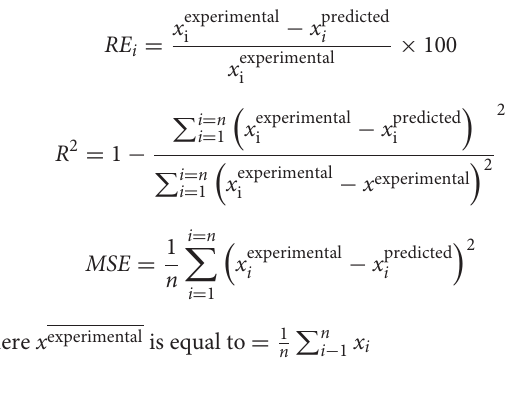
Frontiers in Energy Research |